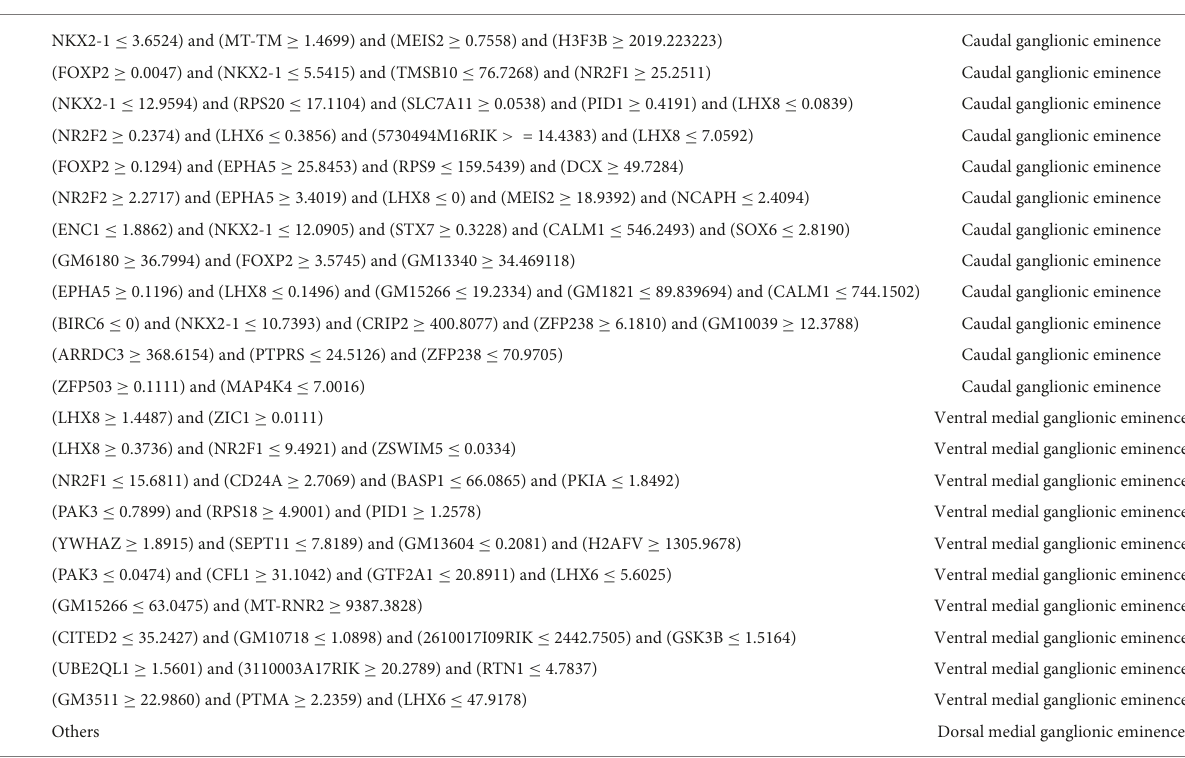
TABLE 2 The 22 classification rules generated by RIPPER for predicting cell